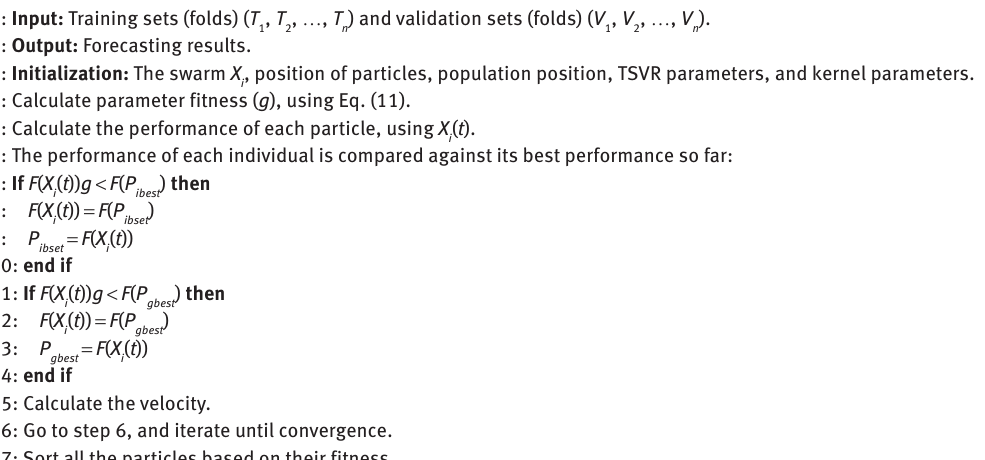
Algorithm 1: PSO-TSVR Algorithm Pseudo